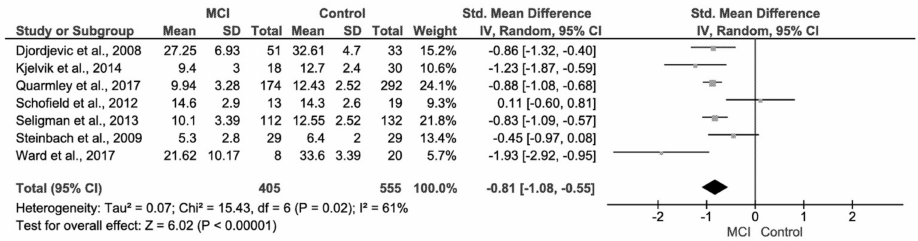
Figure 6. Forest plot comparing odour identification ability between MCI and healthy control